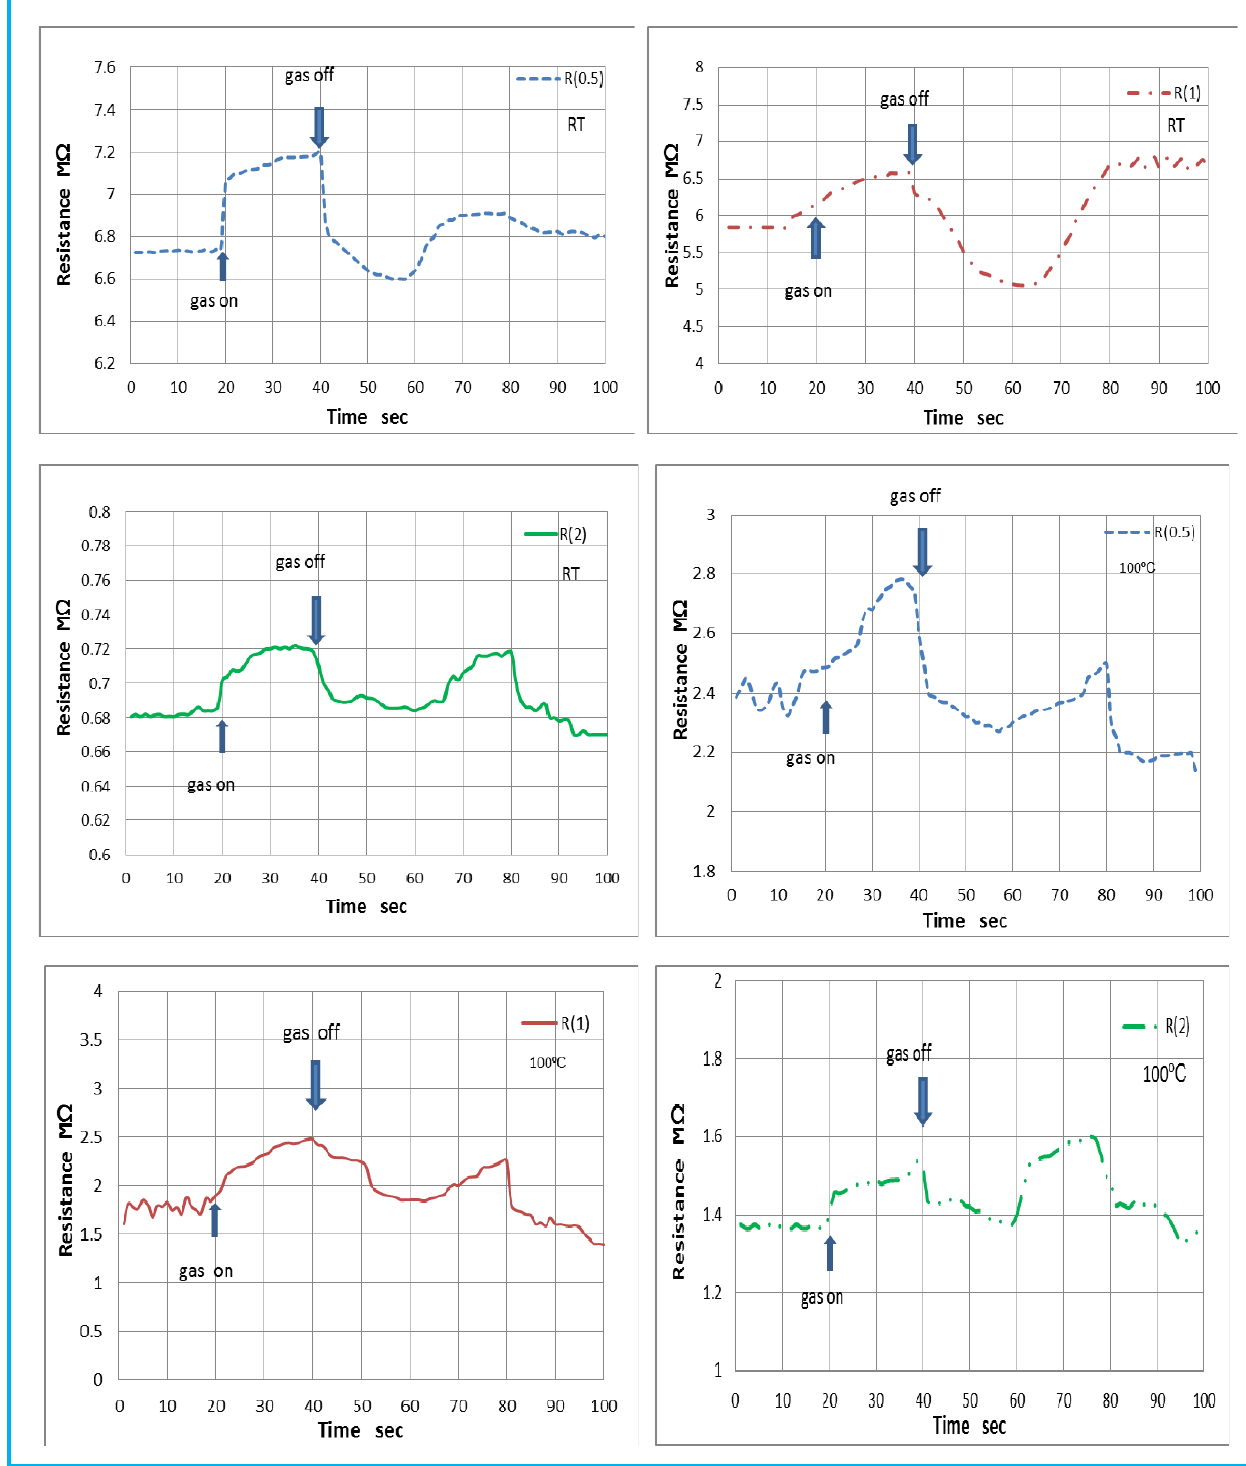
Fig. 9: Resistance as a function of time at different operating temperatures for Si /NiPcTs: PEDOT:PSS bulk heterojunctions blend thin films of different PEDOT:PSS concentrations for NH 3